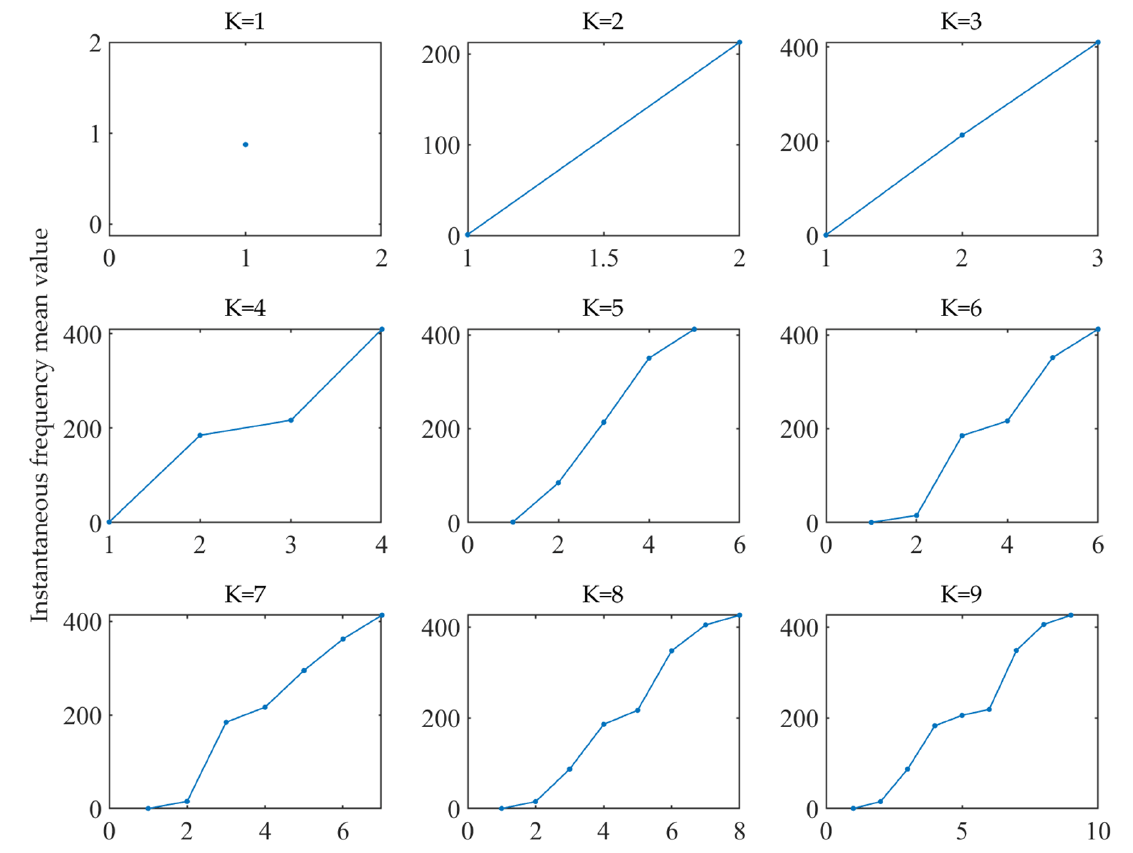
Figure 4. Instantaneous frequency mean value with different K values. Table 1. The main frequency of each IMF